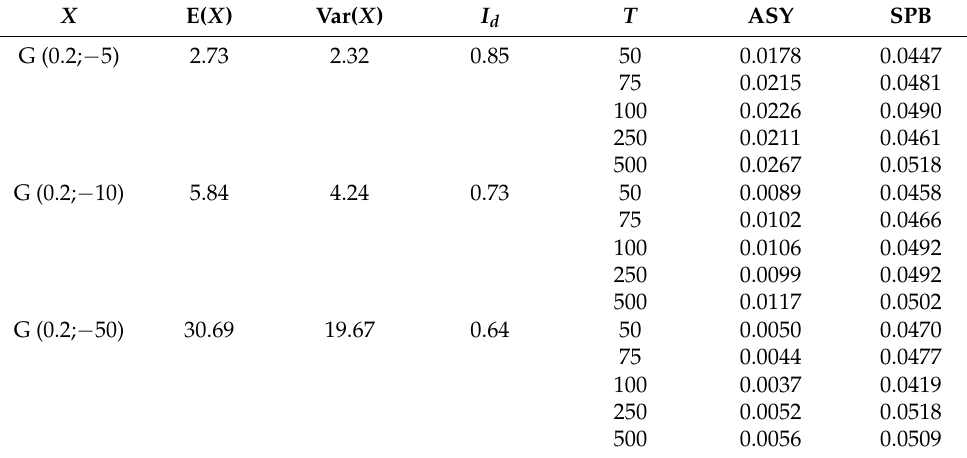
Table A1. Empirical size of the bootstrap-based score test under Good DGP. ASY: asymptotic, SPB: semiparametric